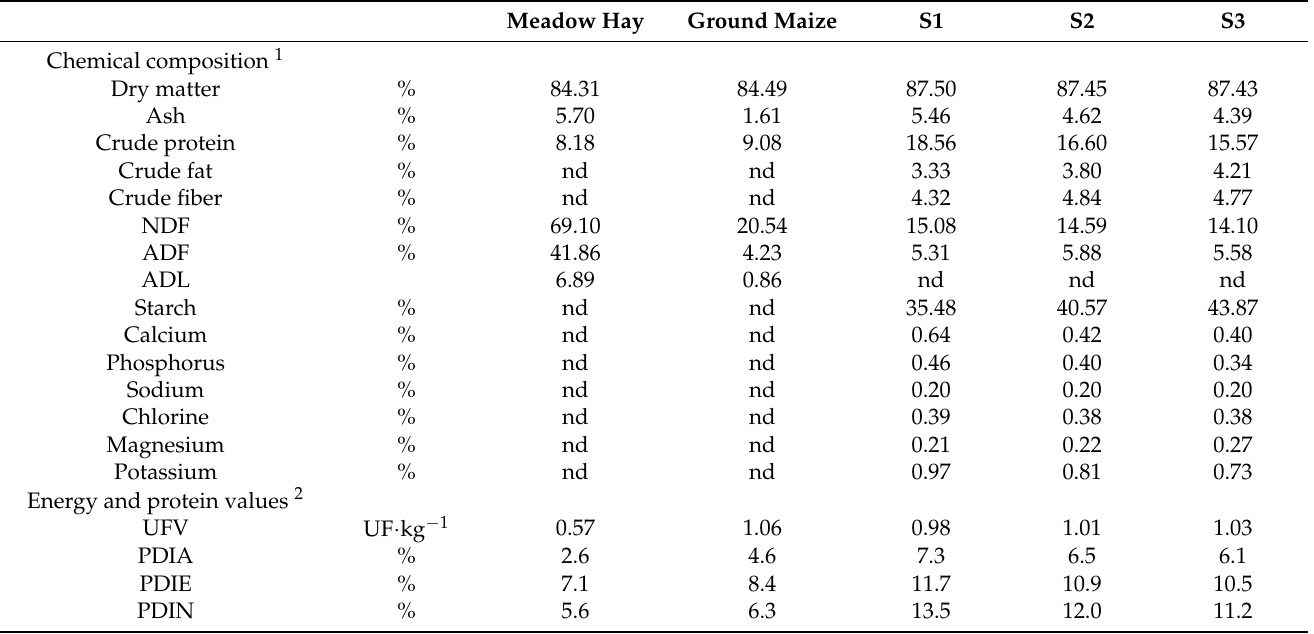
Table 1. Chemical composition and energy and protein values of